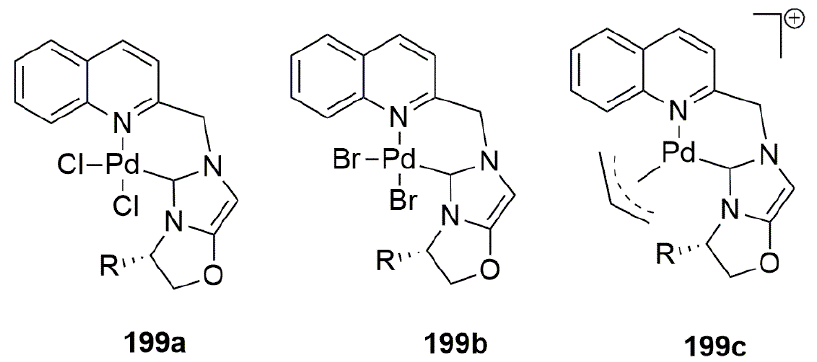
Figure 25. Pd complexes bearing chiral bicyclic imidazoles [197].